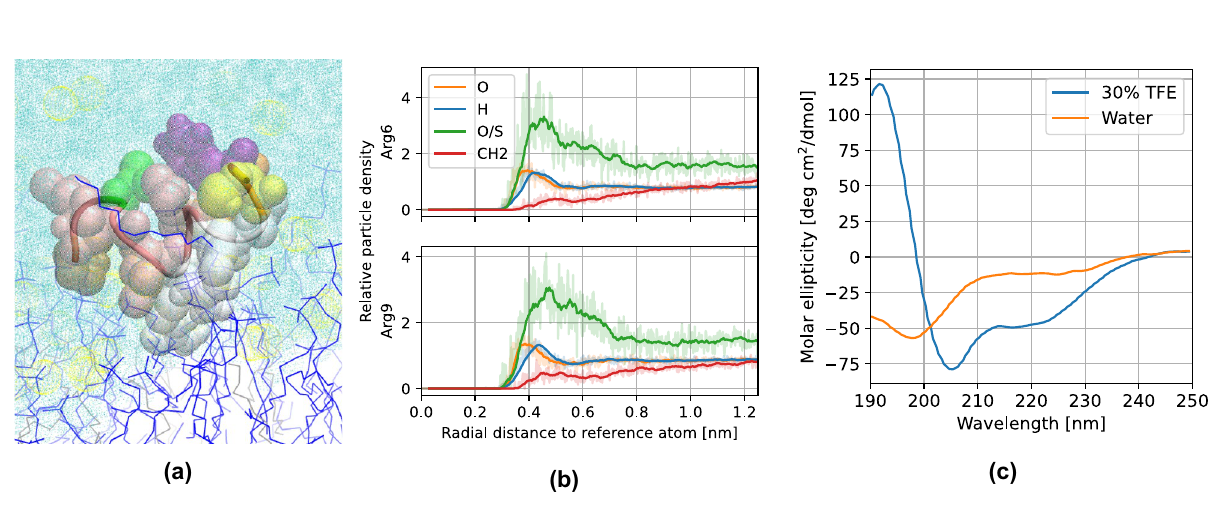
Figure 7. MD simulation of the TP1 peptide penetrating a SDS-based membrane mimetic. ( a ) Single frame of the peptide with its center of mass 2.36 nm away from the bilayer center. Arginine residues are depicted as silver Van der Waals spheres. ( b ) Radial distribution functions of arginine fragments of the peptide upon first interaction with the bilayer. ( c ) Circular dichroism spectra of TP1 peptide in water and 30% TFE